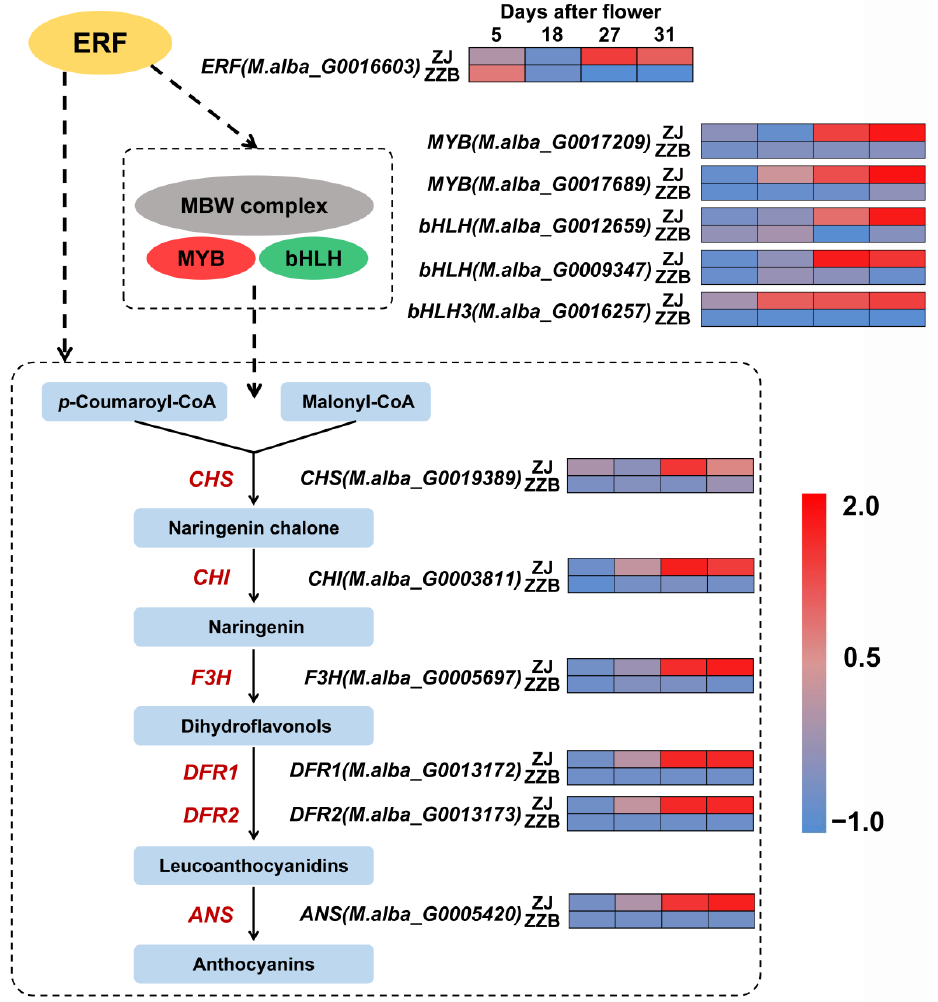
Figure 6. A simplified mechanistic model of the anthocyanin biosynthesis pathway and transcription of key genes in ZZB and ZJ. Each colored cell represents the average log2 (RPKM) value according to the color scale. Red represents high expression and blue represents low expression.